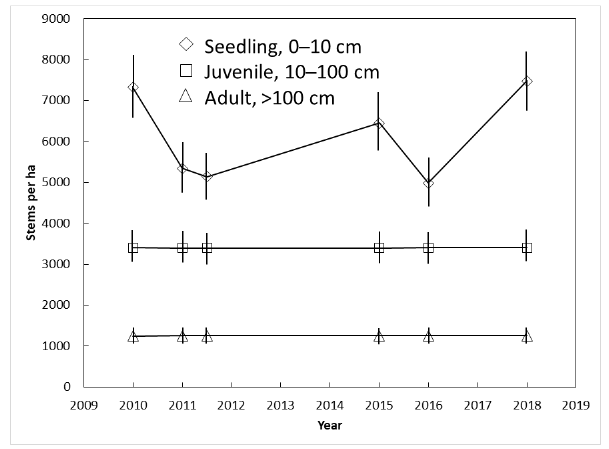
Figure 5. The influence of demography on Cycas micronesica survival among three Yap habitats from 2010 until 2018. Mean ± SE.